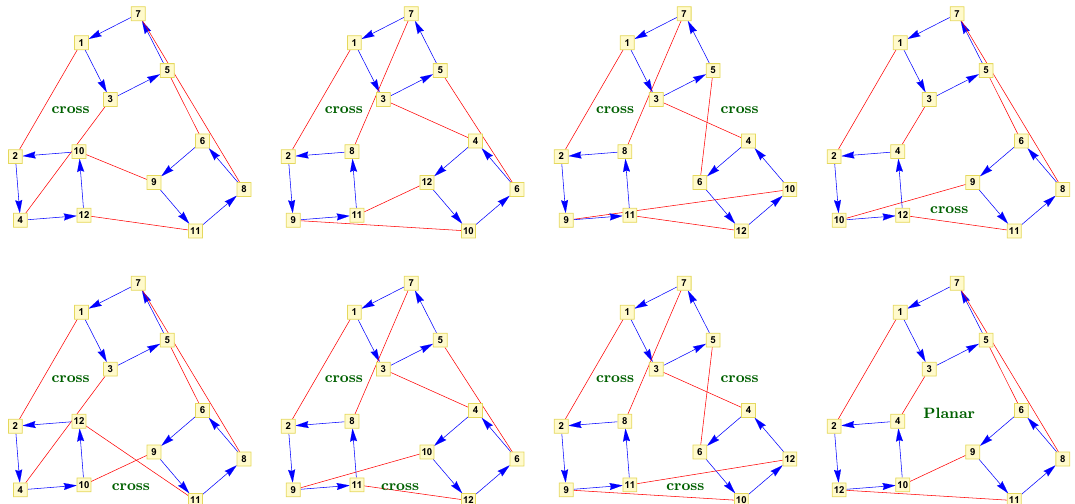
Figure 12 . Original Feynman graphs corresponding to 7 (cid:2) [3 2 ] 2 N 1 and [3 2 ] 2 N 0 in (5.21). The (cid:12)rst 7 graphs are part of the leading non-planar corrections to the three-point function, while the last graph is planar. All of them gives (cid:23) 2 [3 2 ] after the skeleton reduction of section 4.